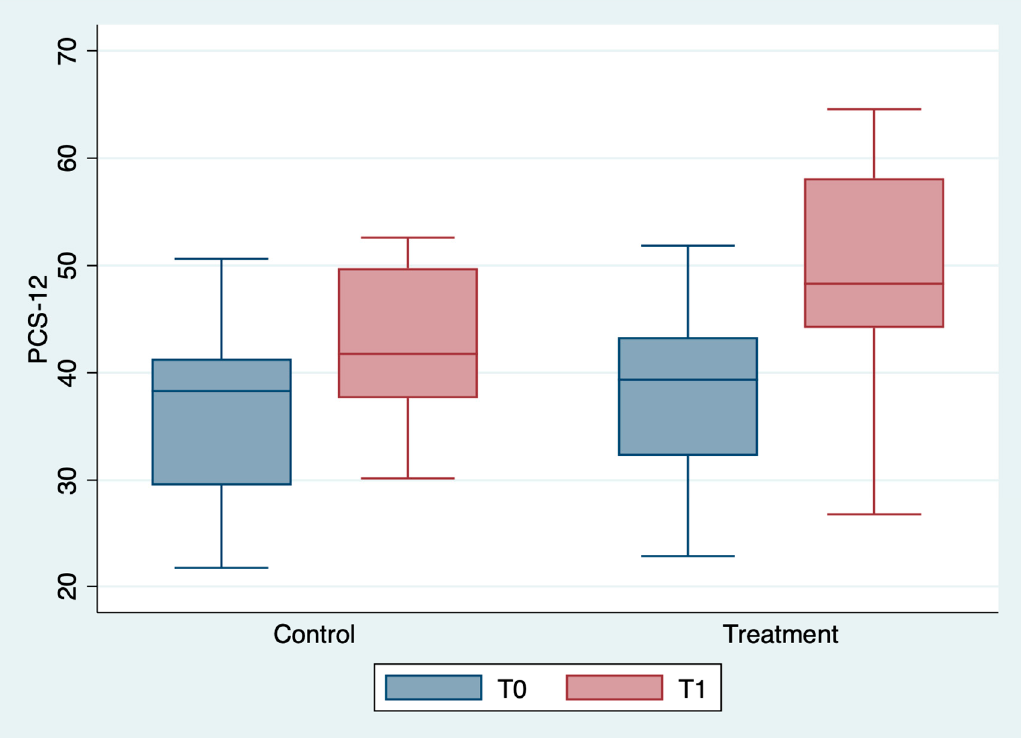
Figure 2. Box plot of ODI values by detection time and group.